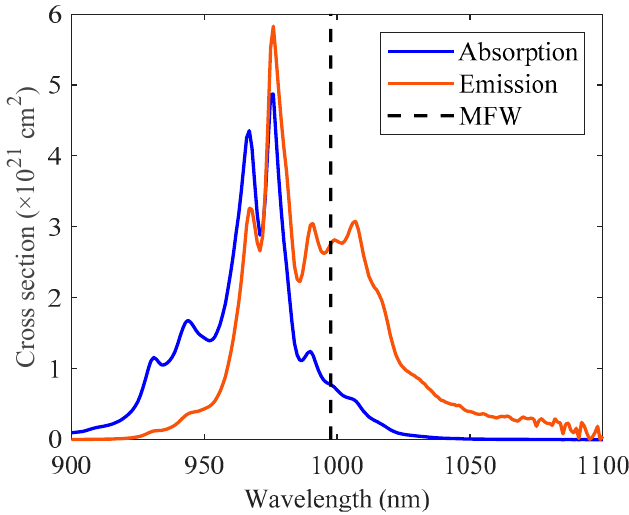
Figure 1. Absorption and emission cross-sections plot for E || c in 10% Yb 3+ :LiYF 4 . The blue curve is the effective absorption cross-section measured by a spectrophotometer, and the red is the effective emission cross-section calculated using the McCumber theory. The dashed vertical line indicates the polarization averaged mean fluorescence wavelength, 997.6 nm.